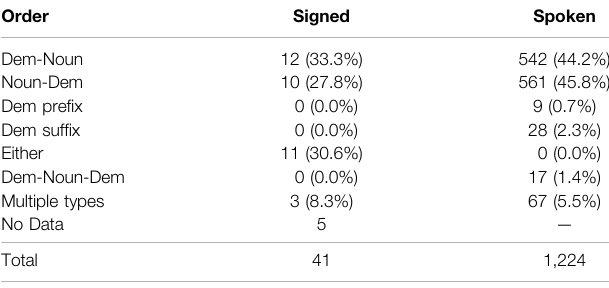
TABLE 5 | Noun/demonstrative order in signed and spoken